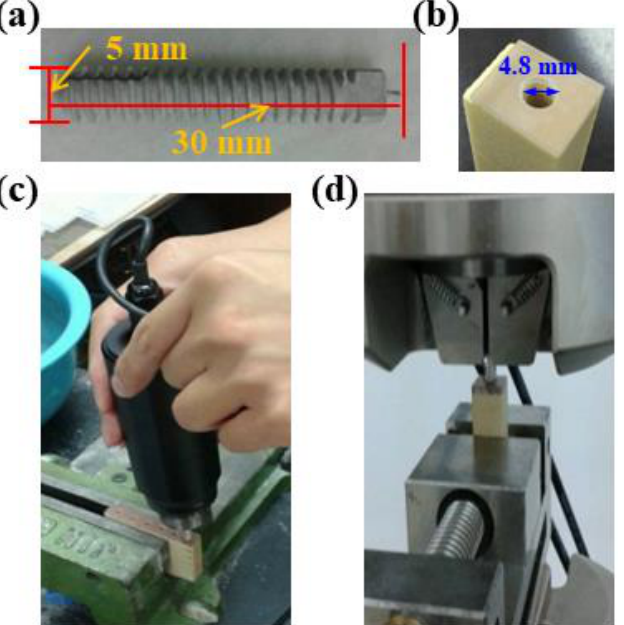
Figure 1. Test setup for the locking force ( a ) bone screw, ( b ) D3 bionic bone, ( c ) custom-made testing, ( d ) pull up testing of the AZ31 Mg alloy bone screw